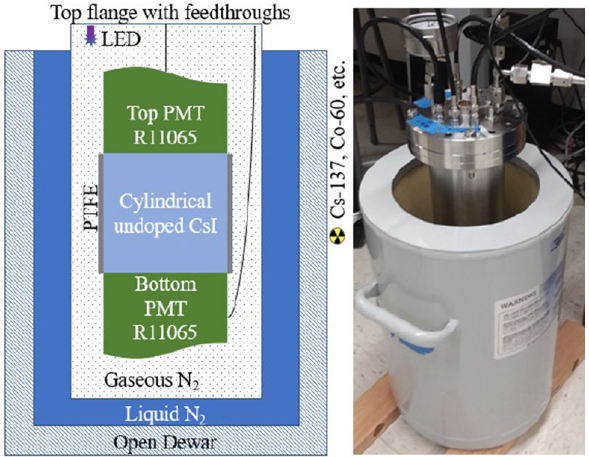
Fig. 1 A sketch (left) and a picture (right) of the experimental setup